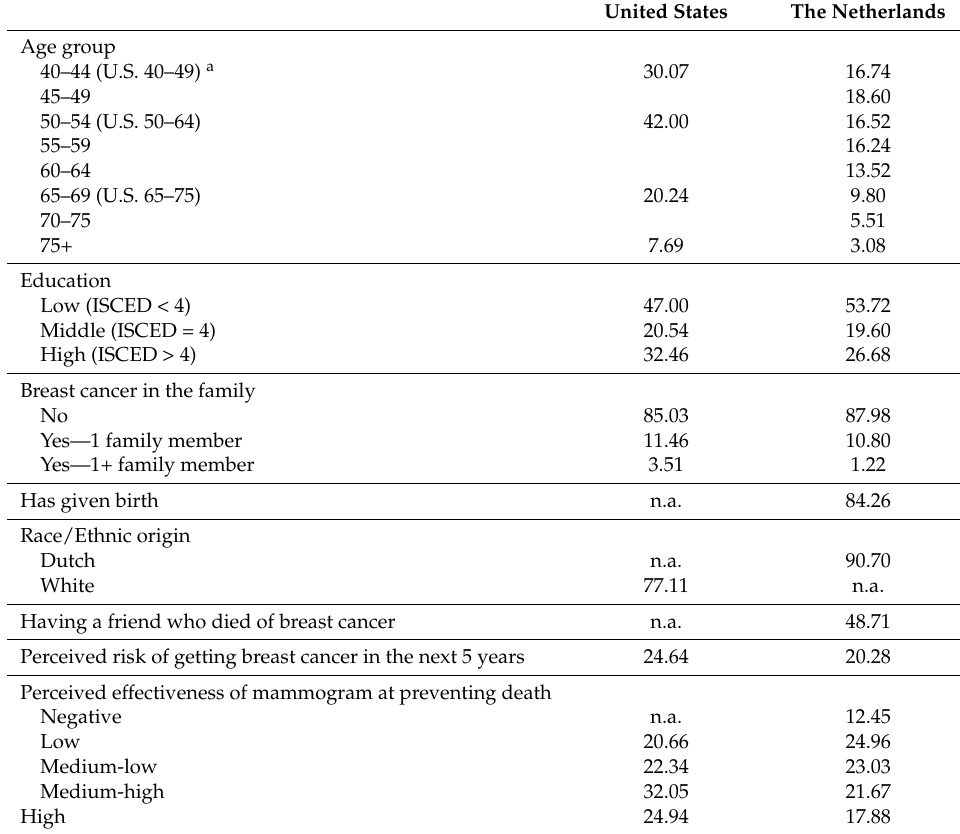
Table 2. Means of control variables by country, women aged